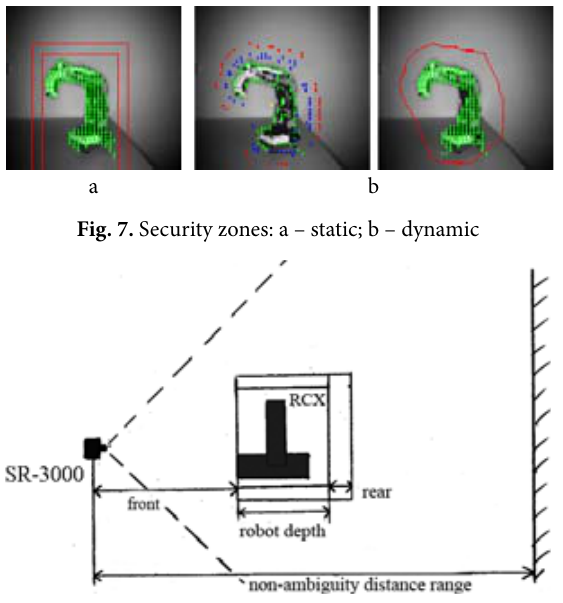
Fig. 8. Monitored